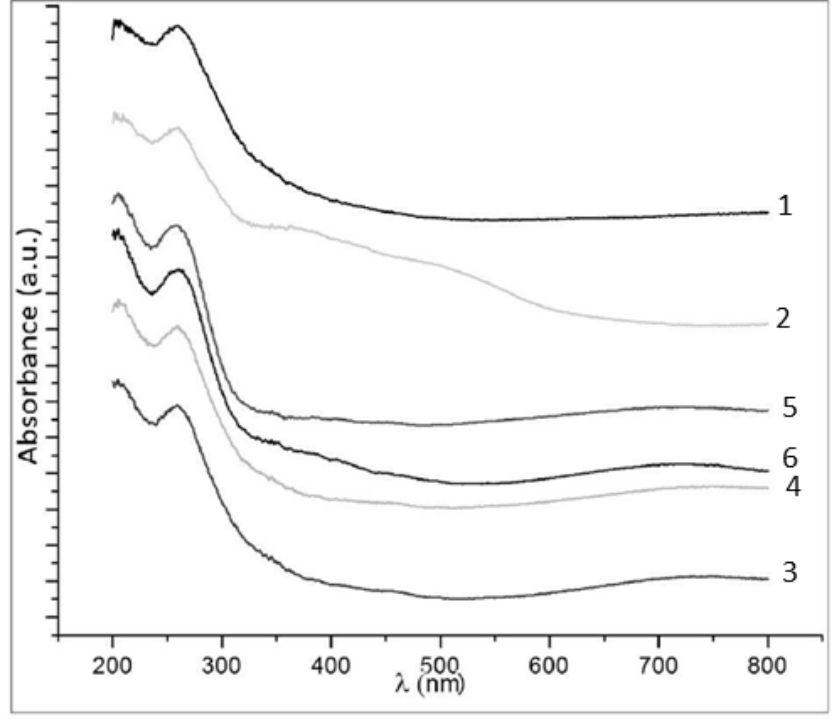
Figure 5. DR-UV–vis spectra of the di ff erent serpentinites: (1) DONAI, (2) FG1, (3) MO-13, (4) MO-9C, (5) MA-2B and (6) MA8.